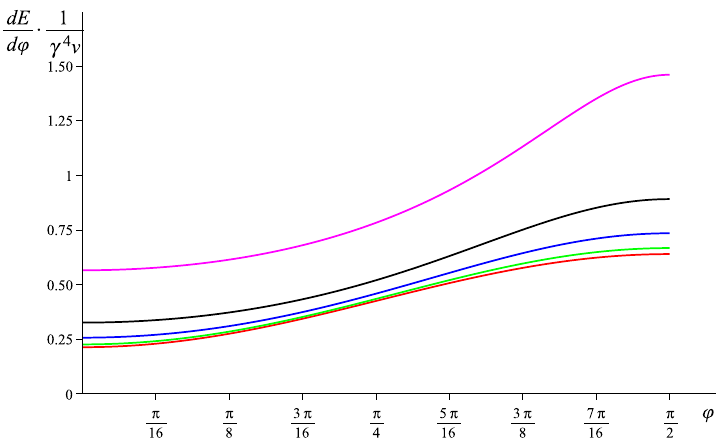
Figure 1. Plots of the ϕ -distribution of the scalar bremsstrahlung, normalized by the overall factor 1/ γ 4 v , in units G = µ = b = f = 1: v = 0.1 (red), v = 0.3 (green), v = 0.5 (blue), v = 0.7 (black), v = 0.9